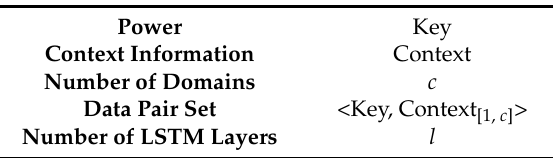
Table 1. Data notation.